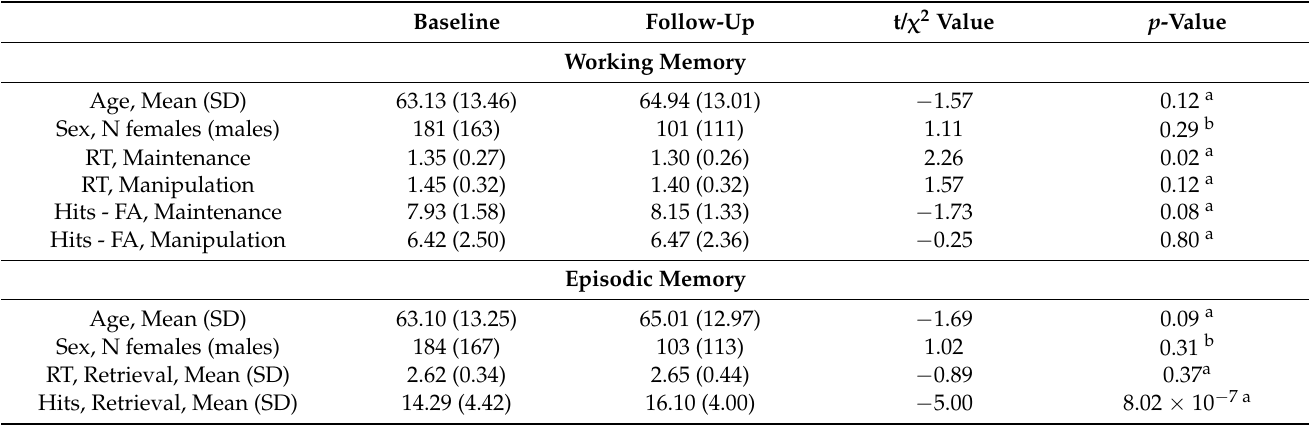
Table 1. Descriptive statistics for baseline and follow-up.